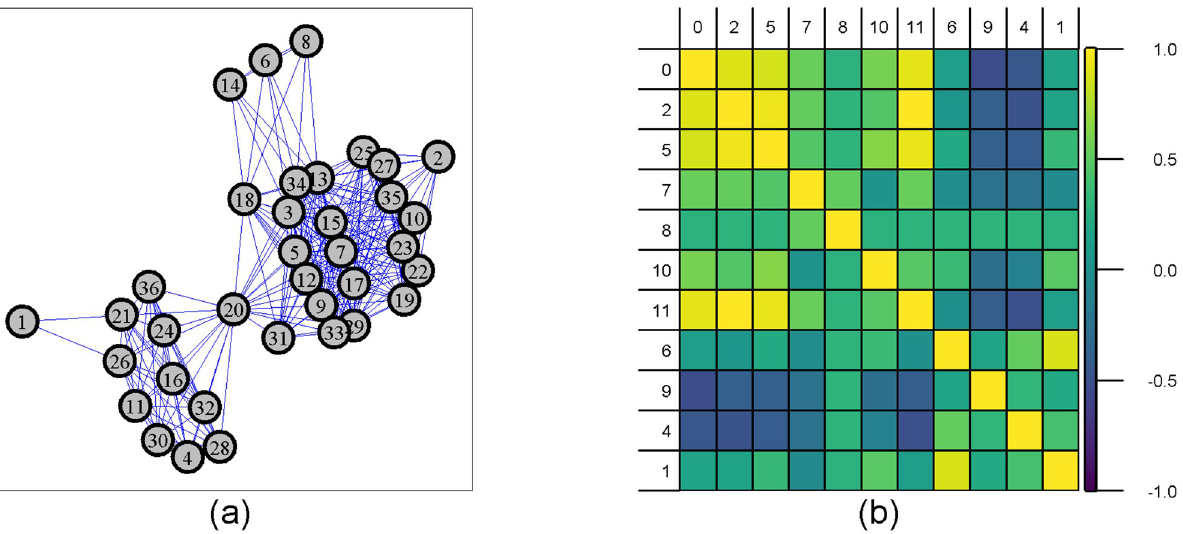
some vessels. Conversely, the strong positive correlations between orbits {0, 2, 5, 7} reflect the existence of a hub such as node 20 [27] which could reflect a strong sociability behaviour. Testing model type. Due to their small orders, some of the empirical graphs (Graph {02;03;04}, red squares in Fig 1b) are out of the synthetic domain of separability. However, being outside the domain of separability does not preclude the use of the test. Being outside of the domain of separability means that it is difficult to systematically separate graphs coming from different models. However, the rejection of the null hypothesis, which reflects the strong dissimilarity between the empirical graph and the null model, remains valid.